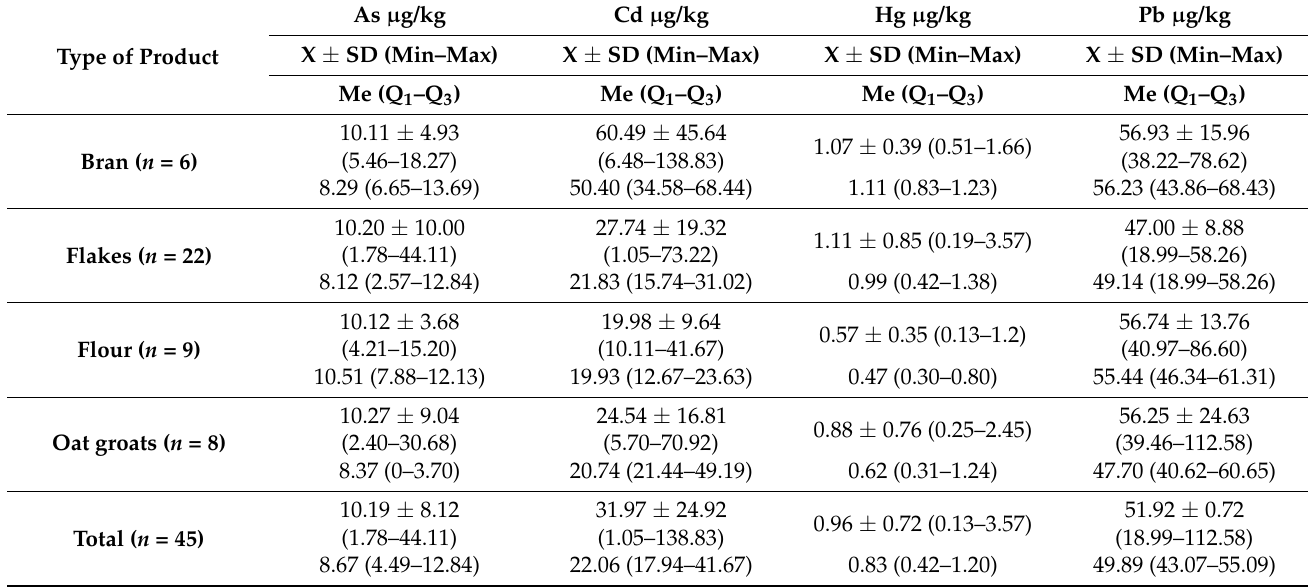
Table 4. The content of the toxic elements in oat